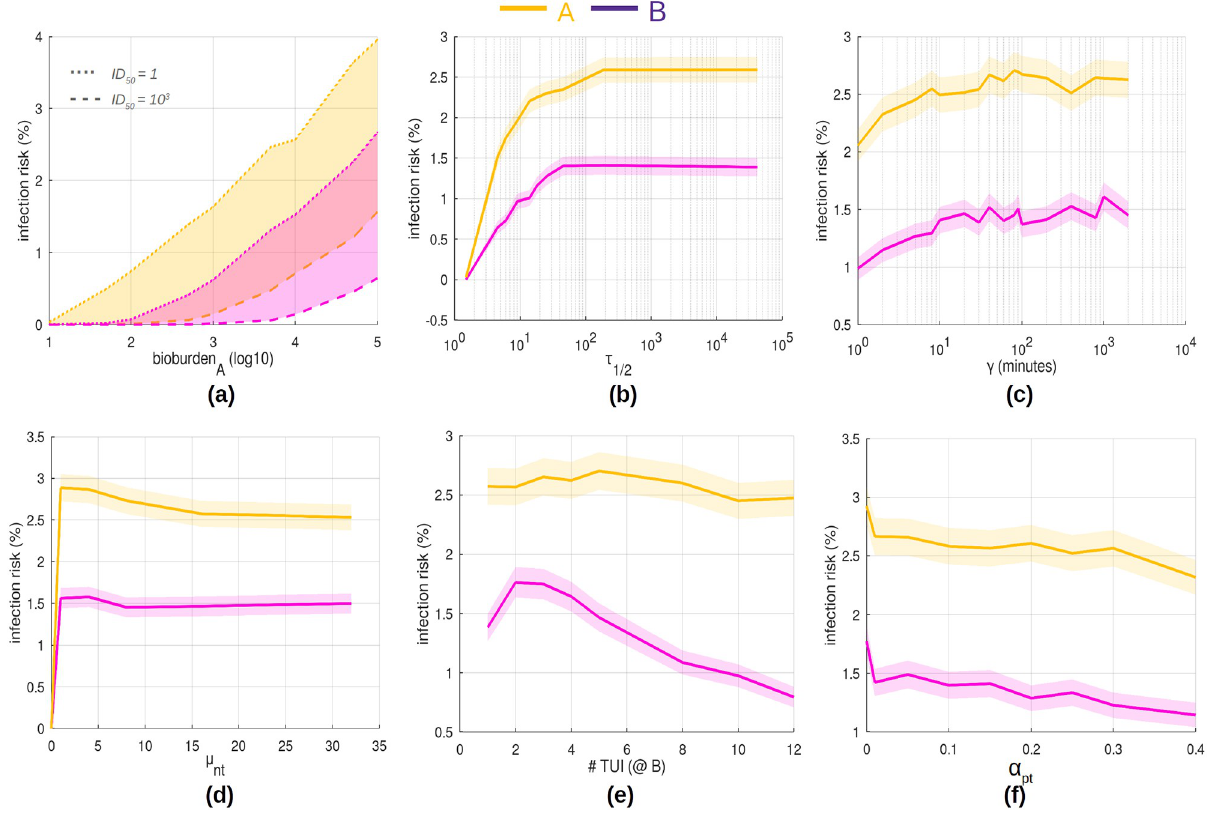
Fig 6. Parameter sensitivity on infection risks. Average infection risk (n = 40000 realisations) with 95% CI. (a) Initial bioburden seeded on TUI A (over a range of ID 50 ) (95% CI omitted for clarity). Bioburdens range from baseline ( * 10 1 ) to ‘heavy’ contamination (10 5 ). (b) Pathogen surface half- life (minutes). (c) Inoculation period (time-constant γ of the dynamic dose response model). (d) Average number of touch interactions, n t required for TUI use. (e) Number of TUIs available for use at B . (f) Deposit rate associated with personal-touching events α